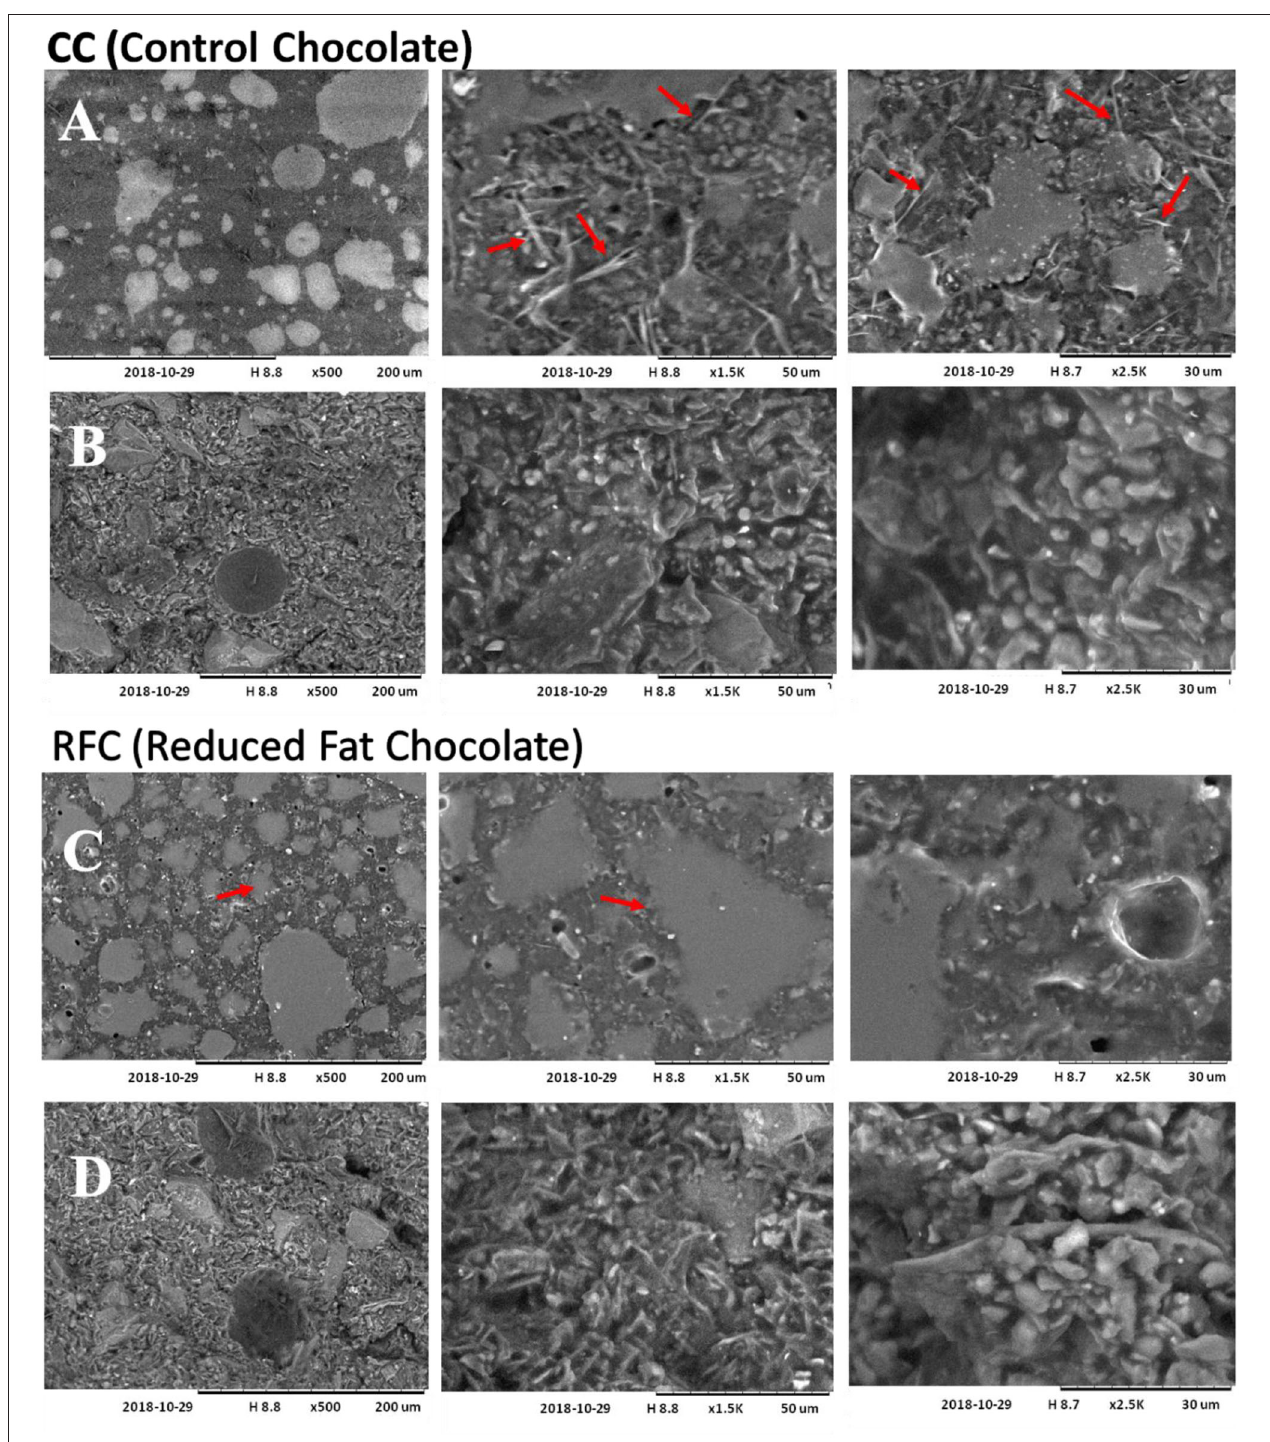
FIGURE 8 | Optical micrograph of control chocolates (CC) and reduced fat chocolate (RFC): Surface (A,C) ; Cross section (B,D) in three different increments 500 (1), 1,500 (2), and 2,500 (3) on day 60 of × ×